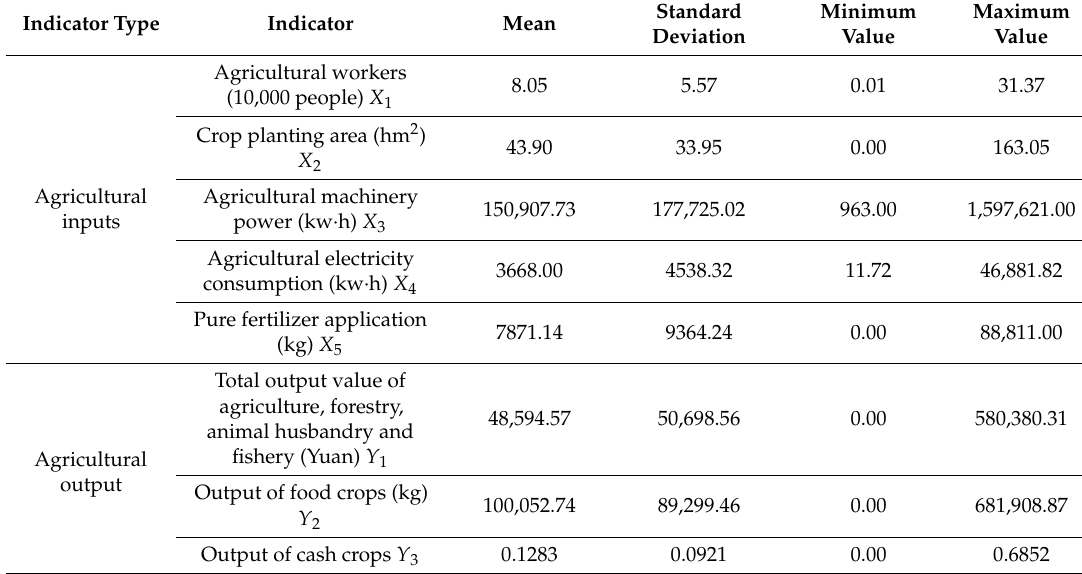
Table 1. Indicator system for evaluating agricultural Total Factor Productivity (TFP) in Gansu Province. Indicator